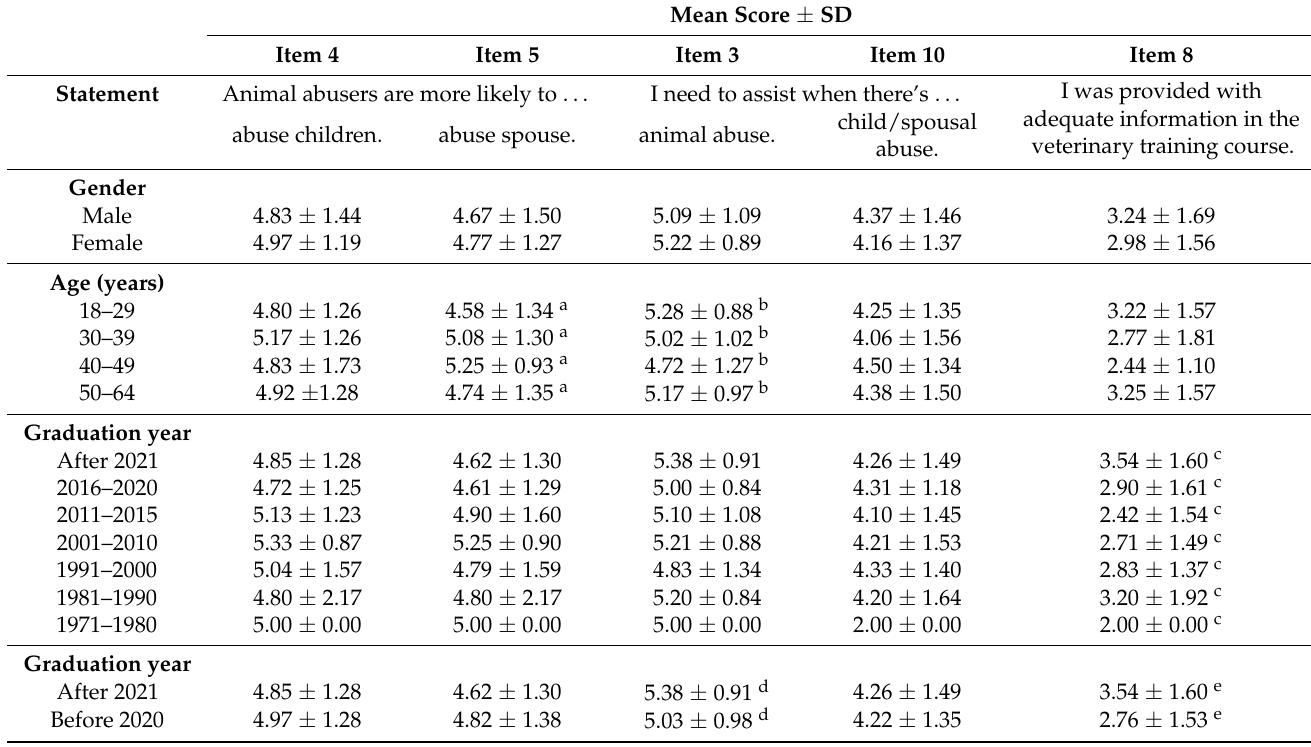
Table 3. Respondents’ demographic characteristics and their responses to the relationship between animal abuse and interpersonal violence and the intention to provide client